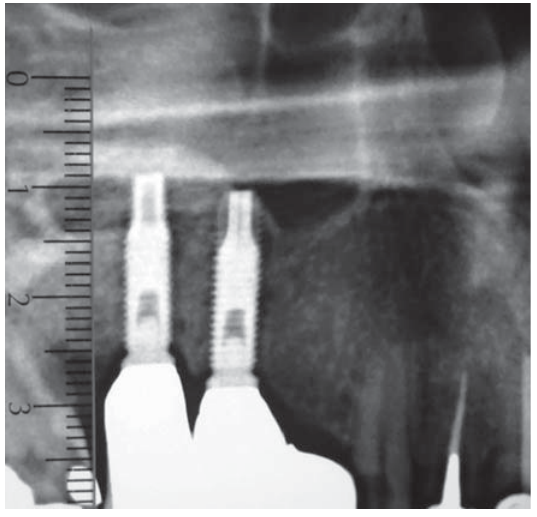
FIGURE 2- The same two implants after 24 months: there is a small bone resorption around the fixture